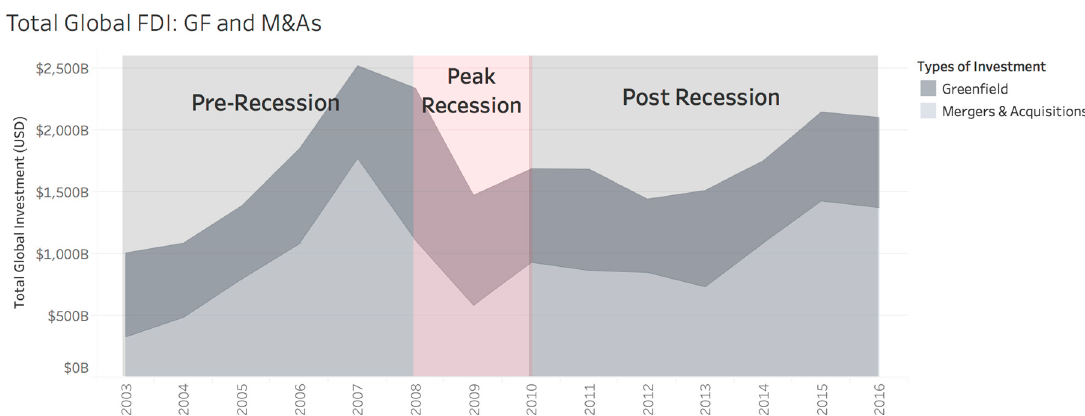
Figure 2. Total foreign direct investments (FDI) and mergers and acquisitions (M&A) deal value across all sectors, split into three phases: (1) pre-recession period 2003–2008; (2) peak recession period 2008–2010; and (3) post-recession 2010–2016. The figure is a stacked area graph representing the total of all the values “stacked” over the time period.